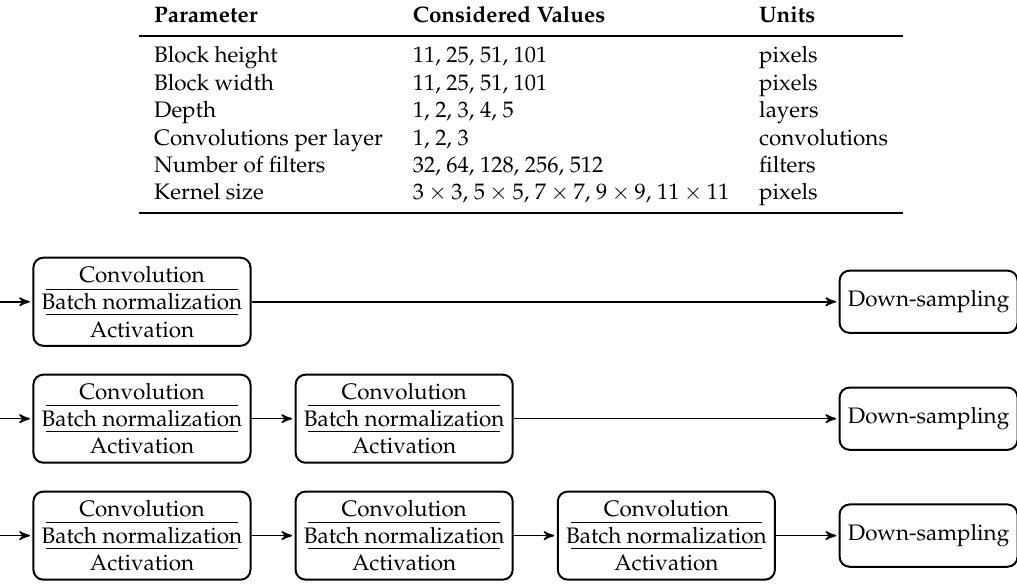
Figure 8. Example of convolutional layers, consisting of a different number of stacked convolution operators with batch normalization and ReLU activation, followed by a down-sampling